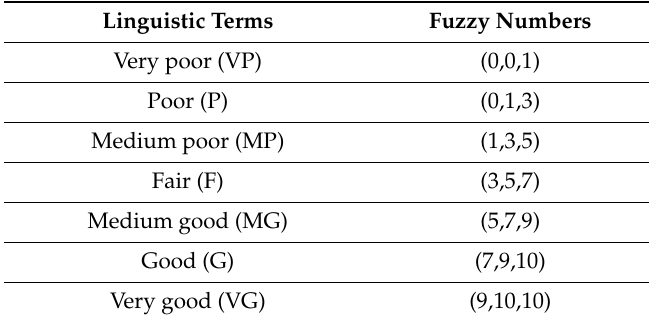
Table 3. Linguistic variables and fuzzy ratings of the alternative.